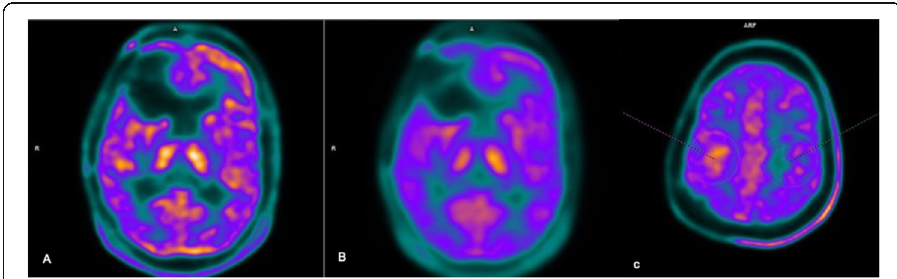
Fig. 1 LIST mode UTE MRAC sequence reconstructed PET images ( A ) and images reprocessed on E7 tools SIEMENS for correction of partial volume effects (PVE) ( B ). 3D ROI was drawn semi-automatically using an individually adapted isocontour of the tumor maximum using a standard ROI with a fixed diameter of 1.6 cm centered on the tumor maximum yielding a volume of 2 ml ( C